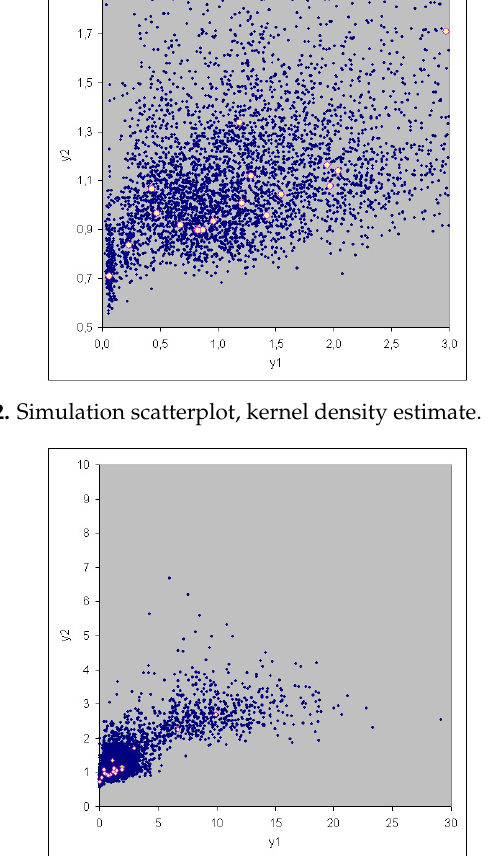
Figure 13. Simulation scatterplot, kernel density estimate. Large scale.